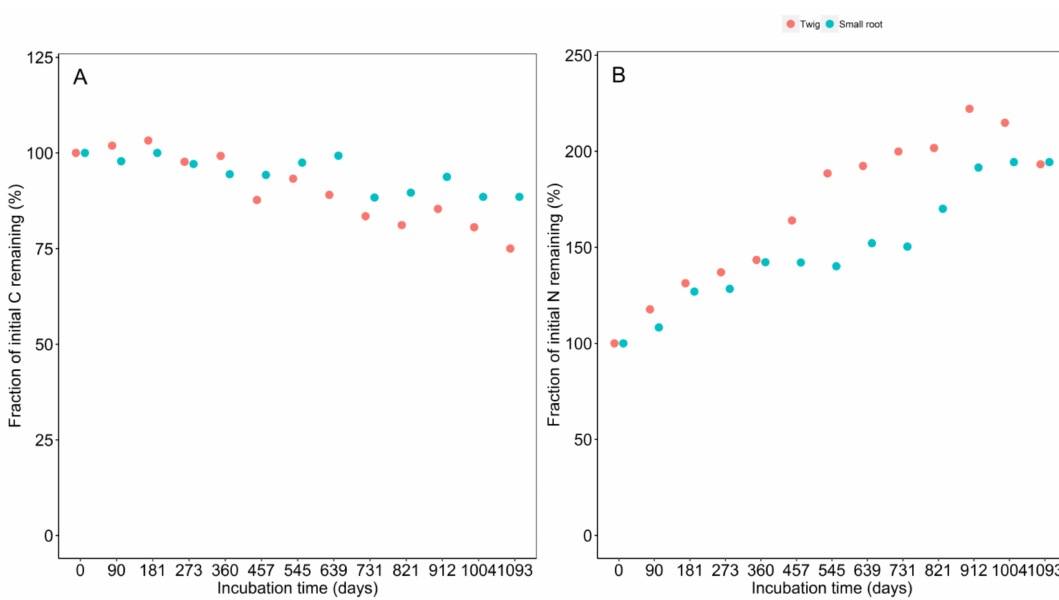
Figure 4. Temporal dynamics in ( A ) the concentration of carbon (C) and ( B ) nitrogen (N) in litter materials of Parashorea chinensis Wang Hsie monitored for 1093 days in Mengla county, Xishuangbanna, China. Twig = red; small root = blue. Dots represent pooled analyses of replicates ( n = 5) harvested at each point in time.